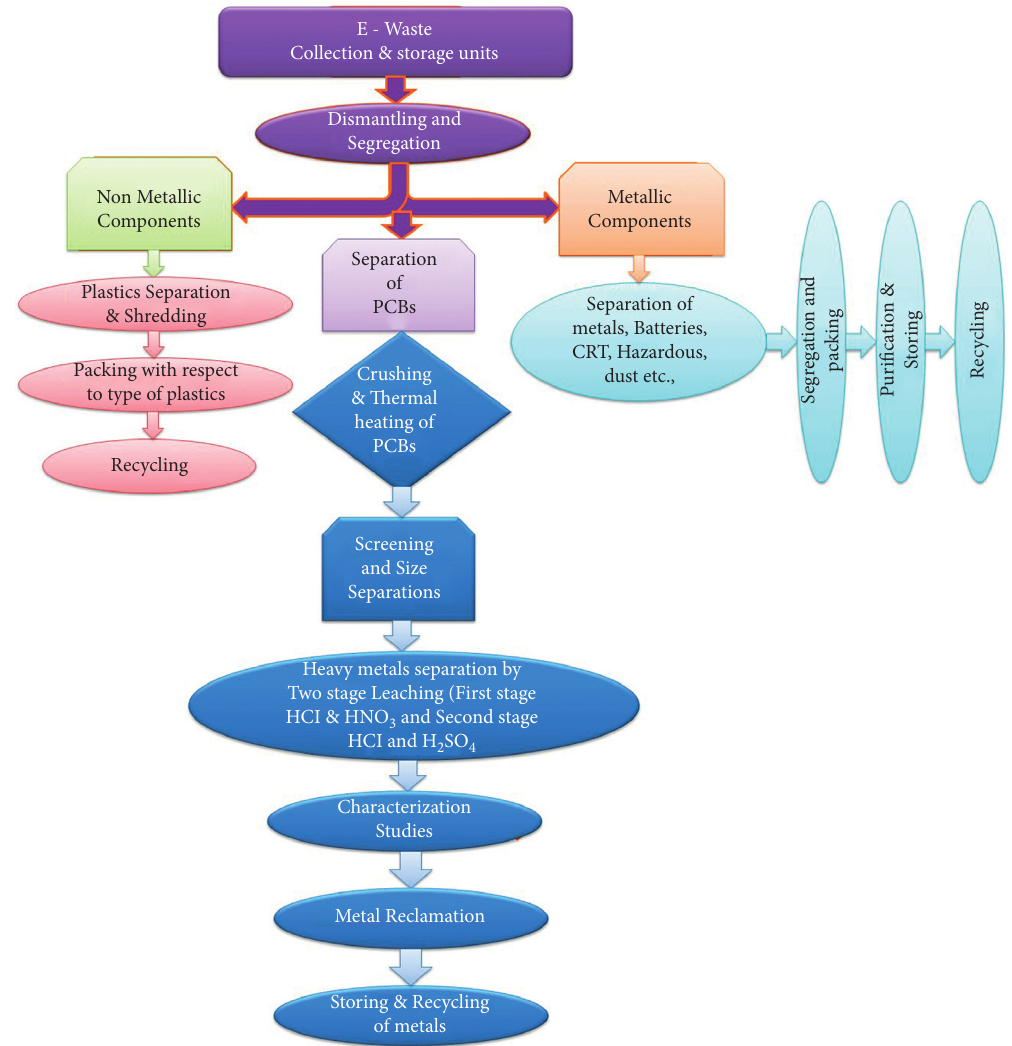
Figure 5: Flow diagram for metal treatment and recovery, and